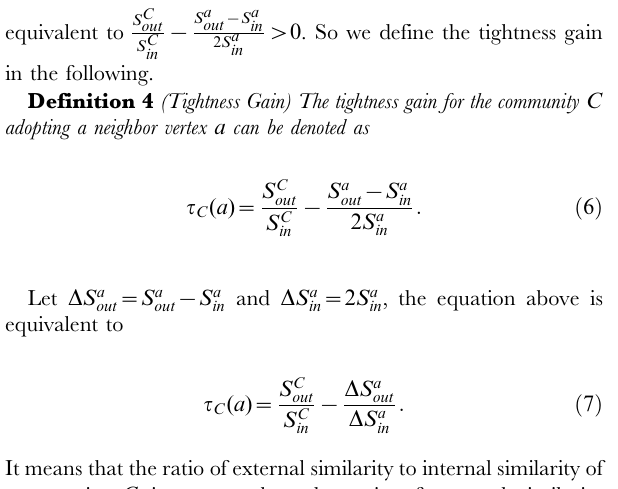
Figure 2. The tightness variant of a community C when a vertex a joins C .